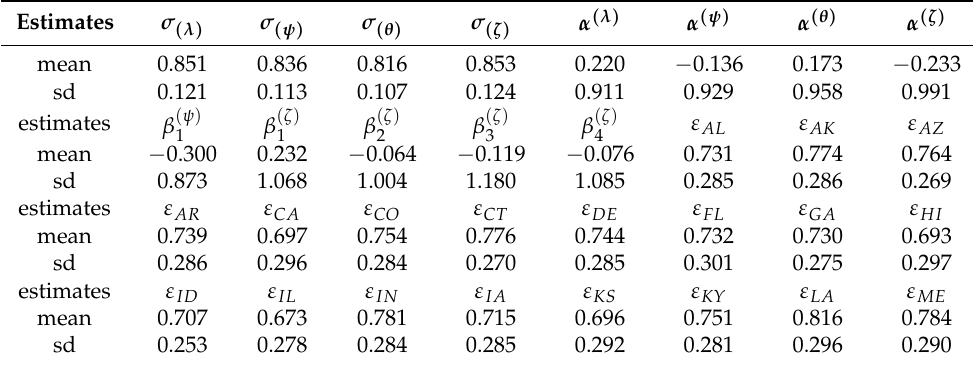
Table 2. Optimal parameter estimates with time lag l = 2. One-hundred different initial processes are randomly implemented. The related mean and standard deviation (sd) are calculated based on 100 ×